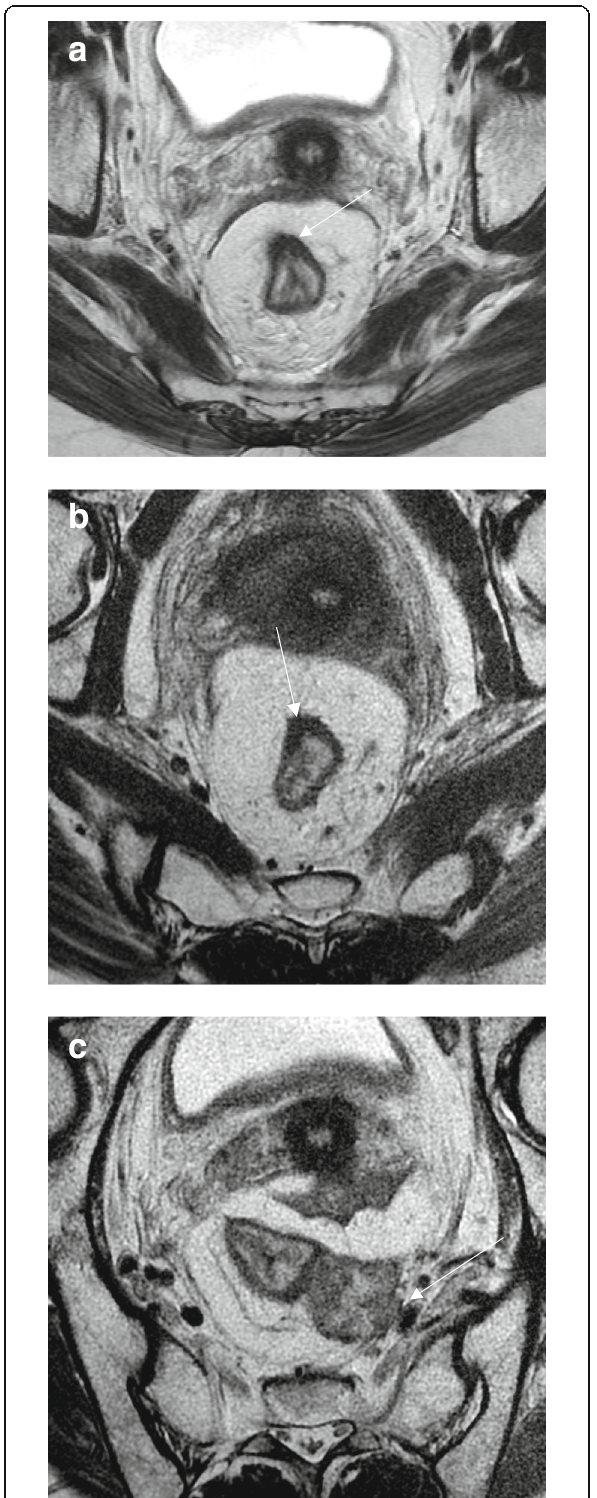
Fig. 16 Mesorectal regrowth. a Axial T2WI shows an anterior low signal intensity scar (arrow). No mesorectal disease was visible. b Follow-up exam after 12 months showed an unchanged low signal intensity scar within the anterior wall of the rectum (arrow). c A large mesorectal lymph node or deposit was visible, threatening the mesorectal fascia (arrow). Total mesorectal excision was